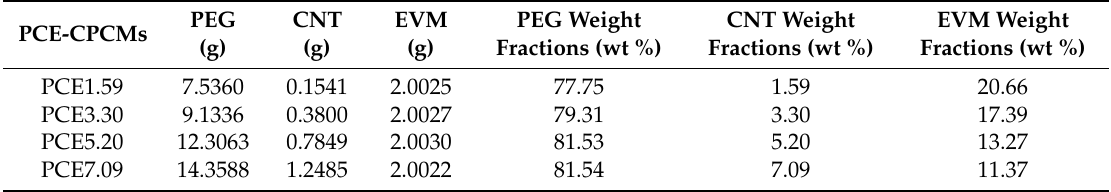
Table 2. Components of the prepared polyethylene glycol (PEG)-carbon nanotubes (CNTs) with expanded vermiculite (EVM) form-stable composite phase change materials